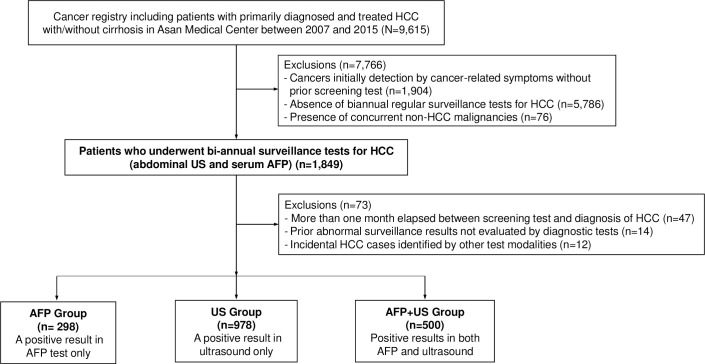
Flow diagram of patient enrollment.